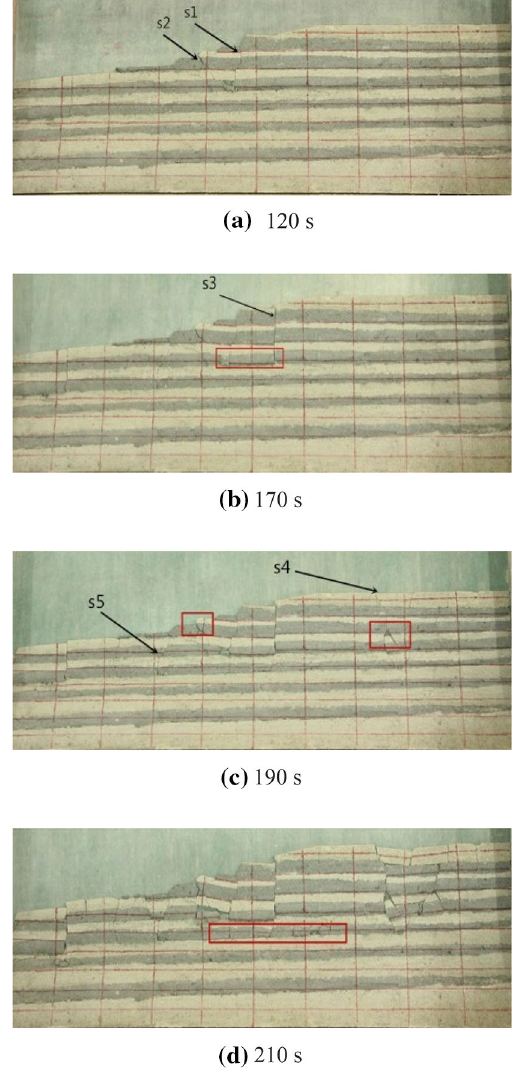
Fig. 11 The slope deformation process